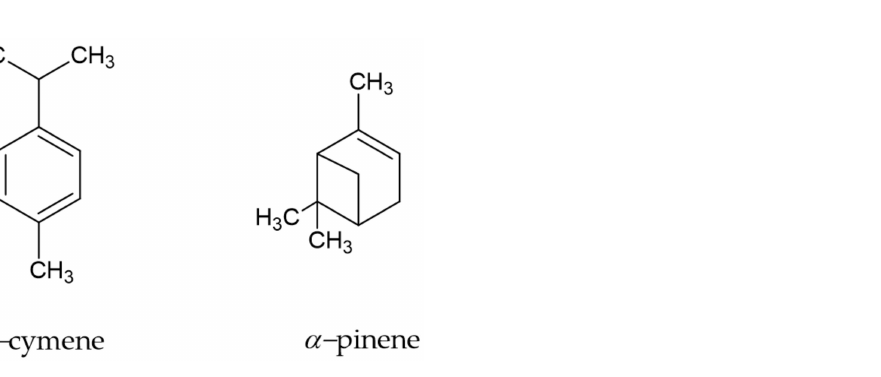
Figure 1. Molecular structure of the major phytochemicals of the P. heptaphyllum resin essential oil.